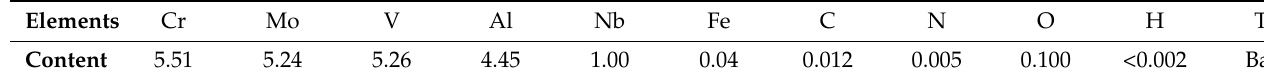
Table 1. Chemical composition of the Ti − 65541 alloy (%, mass fraction).